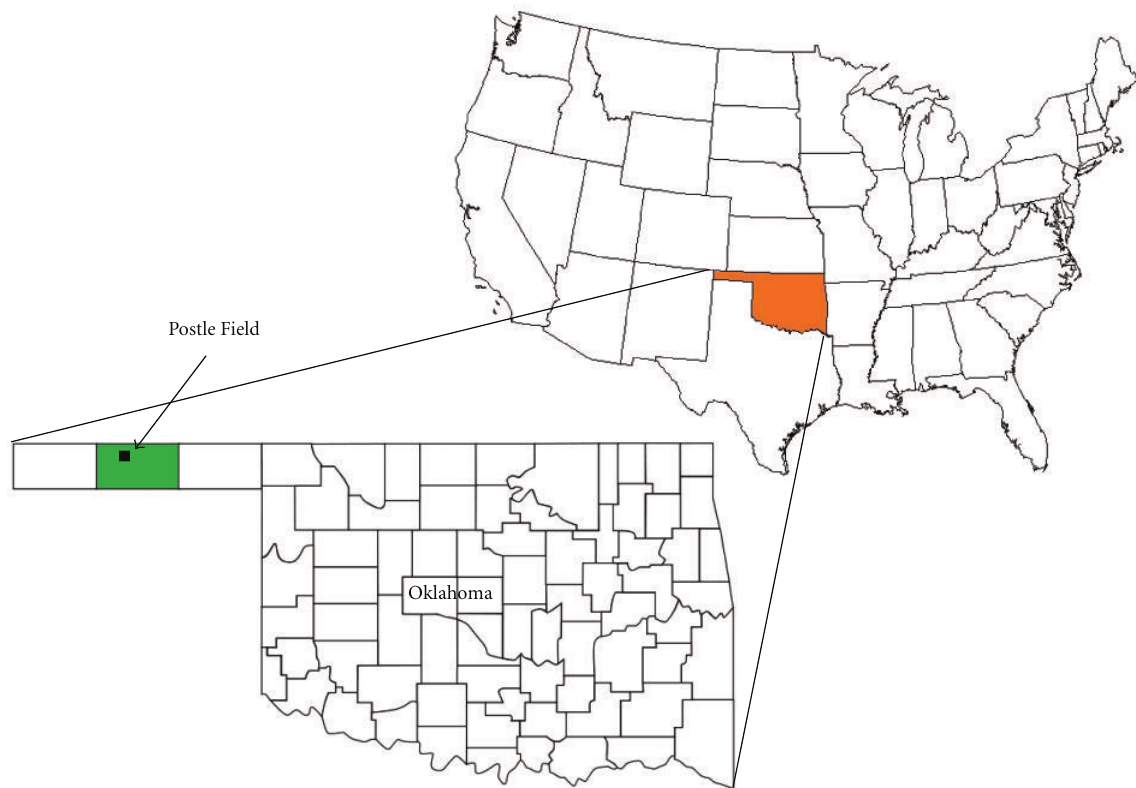
Figure 1: Location of Postle Field in Texas County,